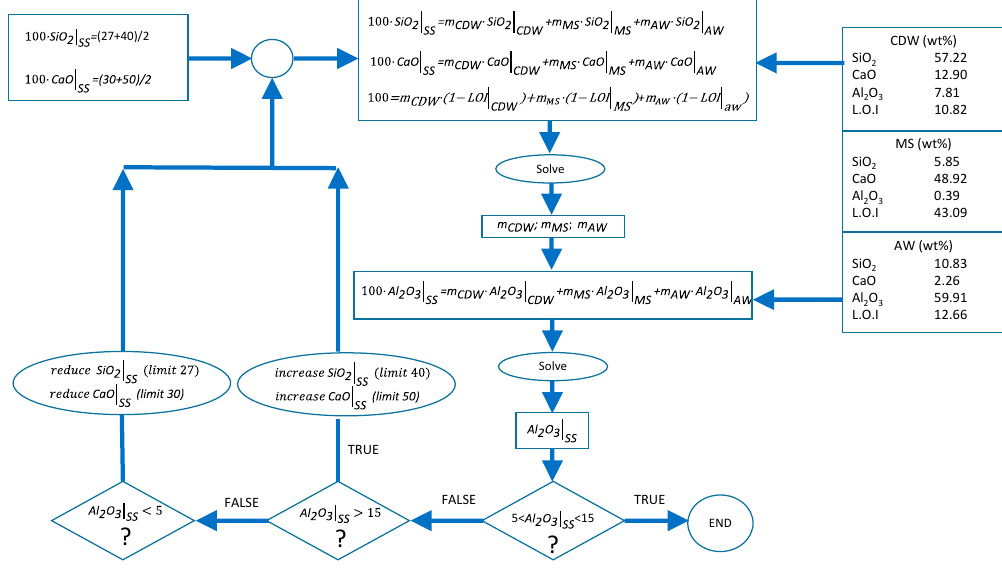
Figure 1. Methodology for waste mixture adjustment.